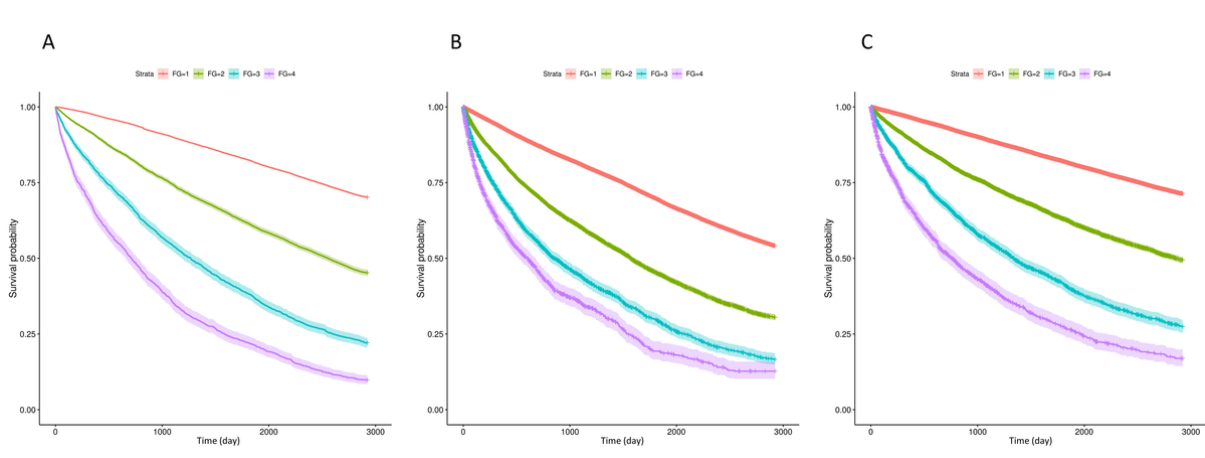
Figure 2. The 8-year Kaplan-Meier survival curve for the outcome of (A) all-cause mortality, (B) unplanned hospitalizations, and (C) intensive care unit admissions for different frailty